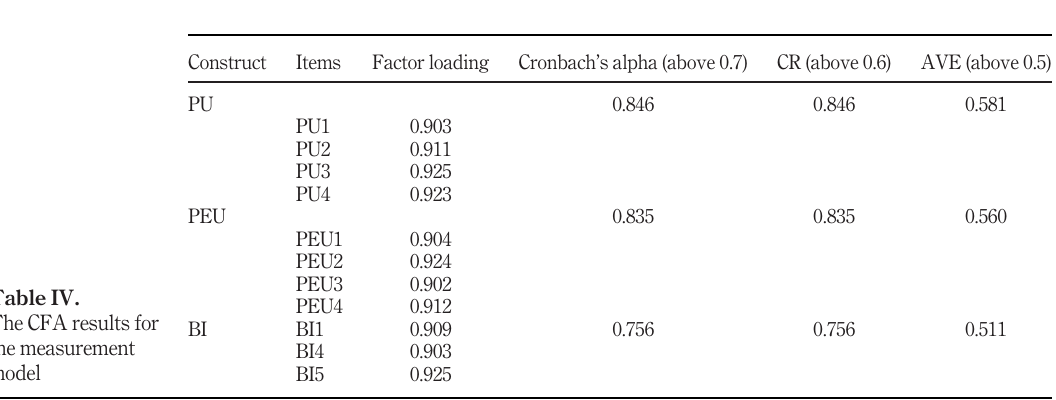
Table III. Final measurement